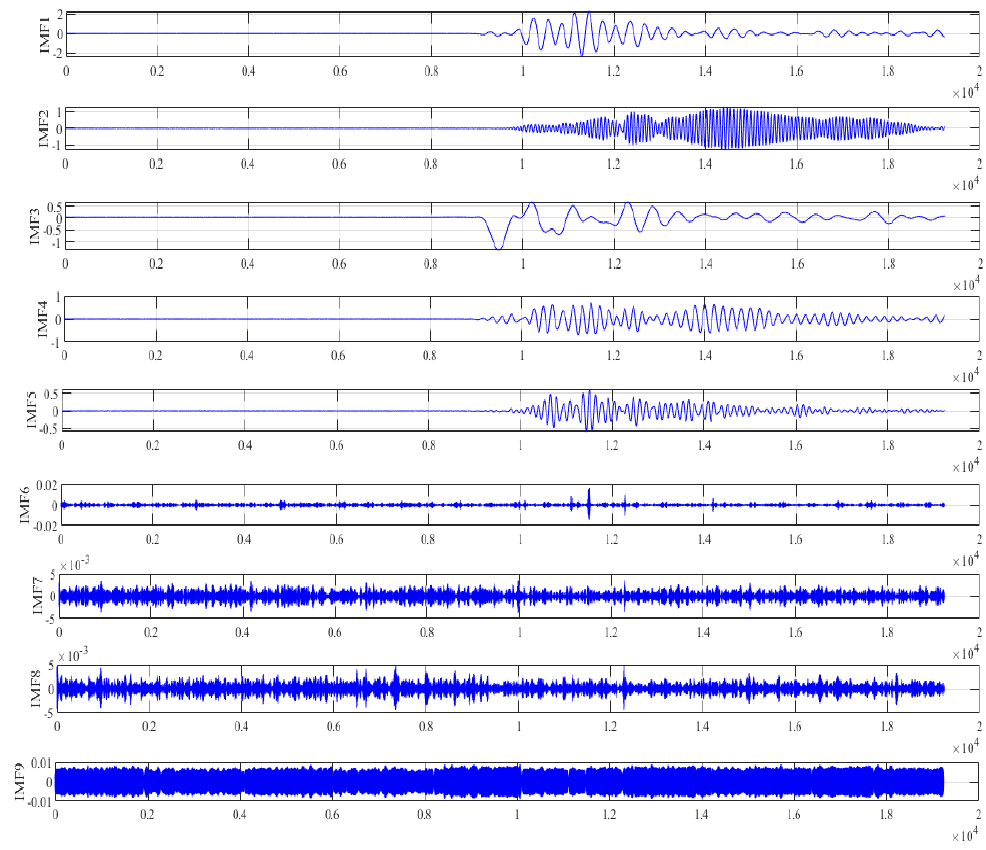
Figure 14. VMD decomposition of the output signal.